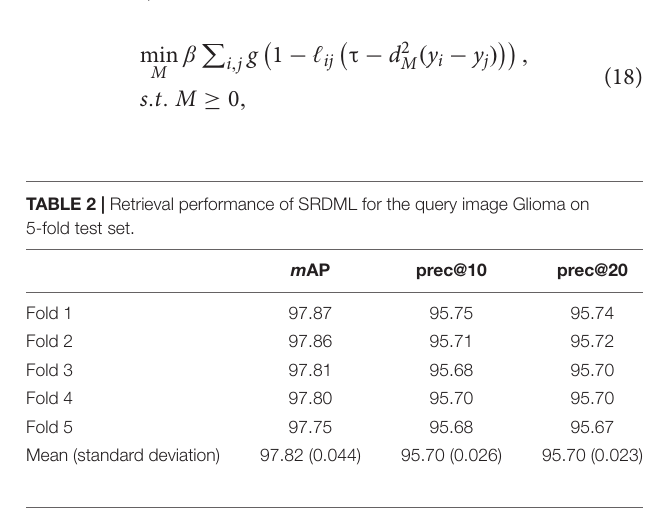
TABLE 3 | Retrieval performance of SRDML for the query image Pituitary on 5-fold test